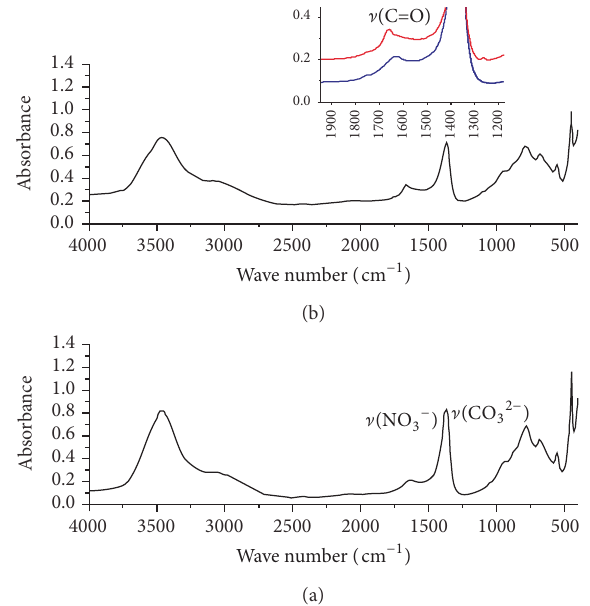
Figure 2: Fourier-transform infrared spectra for the hydrother- mally treated layered double hydroxide (HT-LDH) before (a) and after (b) palladium incorporation. Inset: zoom of the 1900– 1200 cm −1 regionofbothspectrasignalingintheupperspectrumthe band relative to C=O stretching mode of N,N